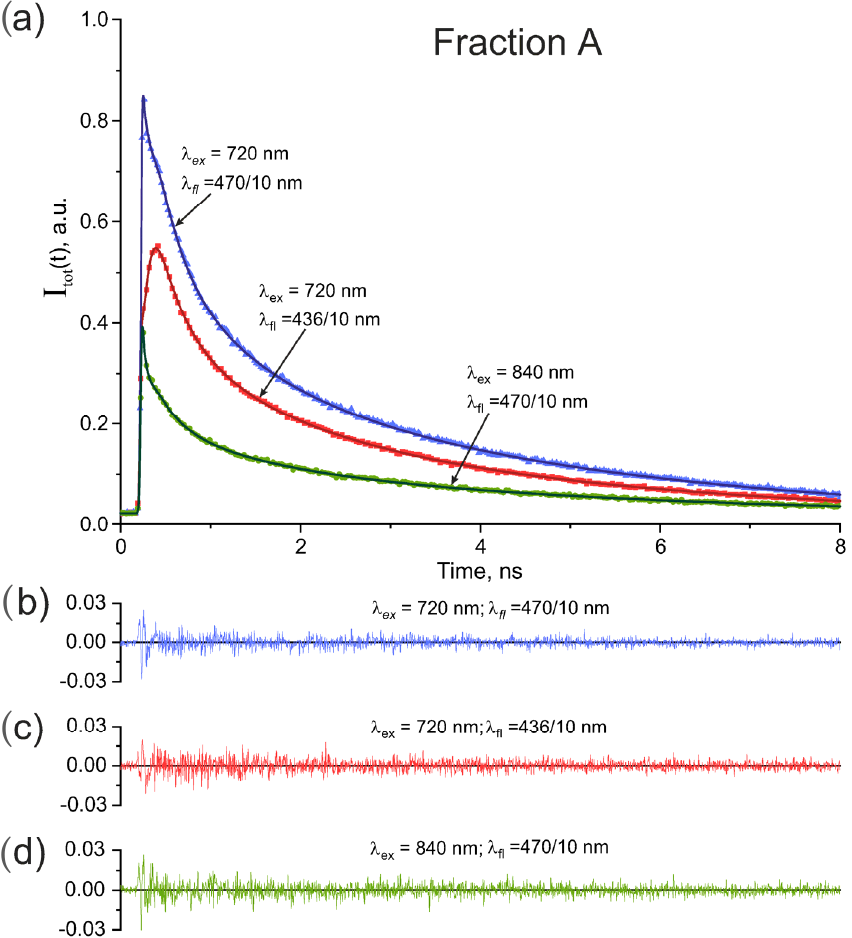
Figure 4. ( a ) Polarization-insensitive fluorescence decay curves in fraction A under two-photon excitation at 720 and 840 nm recorded through the fluorescence spectral windows of 470/10 nm and 436/10 nm. Experimental signals are given with blue, red, and green dots and solid lines are fits. ( b – d ) residuals used for control of the fit